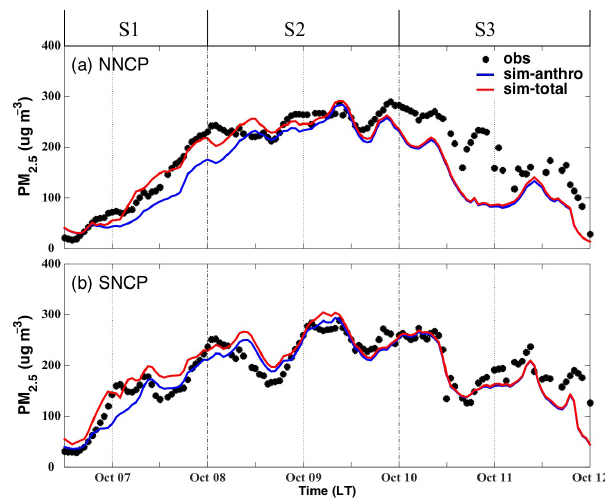
Figure 7. Hourly PM 2 . 5 concentration of observations (obs) and simulations (sim-total and sim-anthro) in (a) NNCP and (b) SNCP; “sim-total” represents the simulations considering total emissions (anthropologic and crop field burning), whereas “sim-anthro” is the simulations only considering anthropologic emissions.